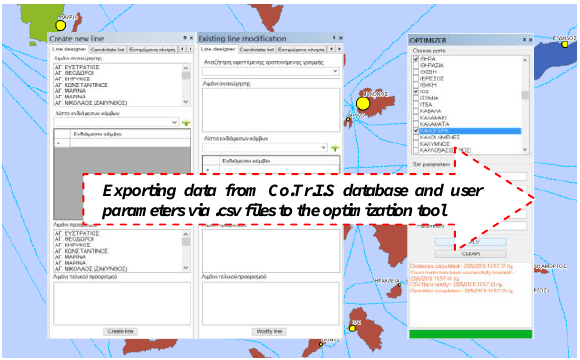
Figure 4. Data extraction for the design/optimization tool.